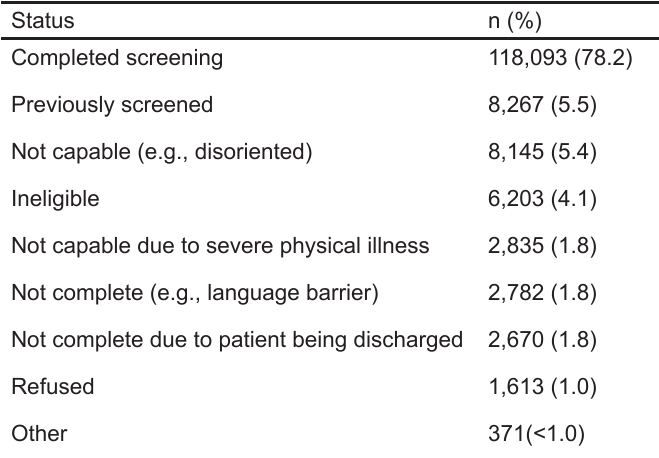
Table 1. Results of attempts to screen 150,979 patients for alcohol and illicit drug use.